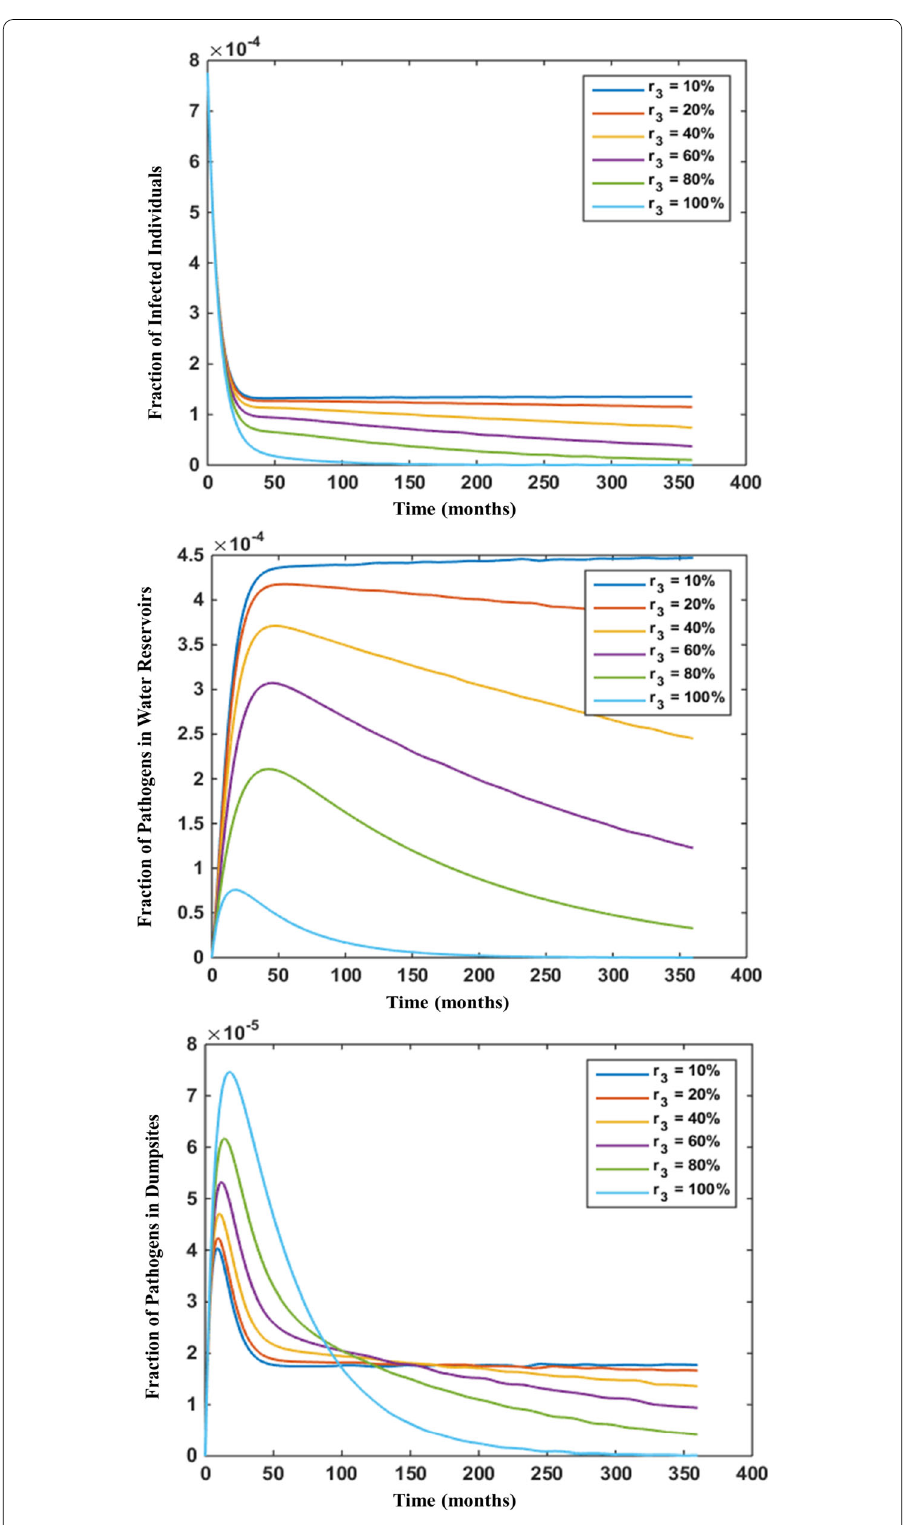
Figure 6 Dynamic behavior of the fraction of infected individuals (top), fraction of pathogens in water reservoirs (middle), and fraction of pathogens in dumpsites (bottom), with r 1 = 65%, r 2 = 35%, and varying r 3 from 10%, 20%, 40%, 60%, 80%, and